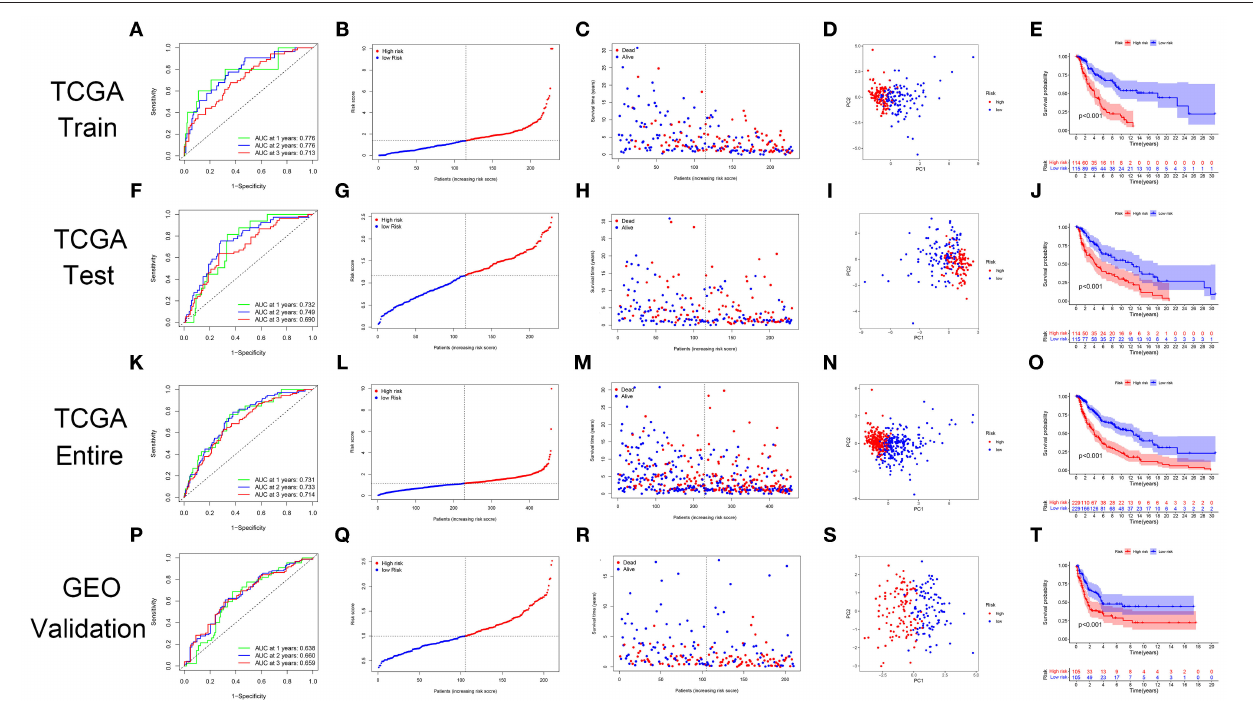
FIGURE 4 | The GRIP signature has prognostic significance in patients with CM. (A) ROC curve in the TCGA training cohort. (B,C) The risk scores and statuses in the TCGA training cohort. (D) PCA of the TCGA training cohort. (E) Kaplan-Meier survival curves of the high- and low-risk groups in the TCGA training cohort. (F–I) The risk signature was verified in the TCGA testing cohort. (J) Kaplan-Meier survival curve of the patients in the TCGA testing cohort. (K–O) The risk signature was verified in the TCGA entire cohort. (P–T) The GEO dataset GSE65904 was used as an external validation dataset to verify the risk signature.